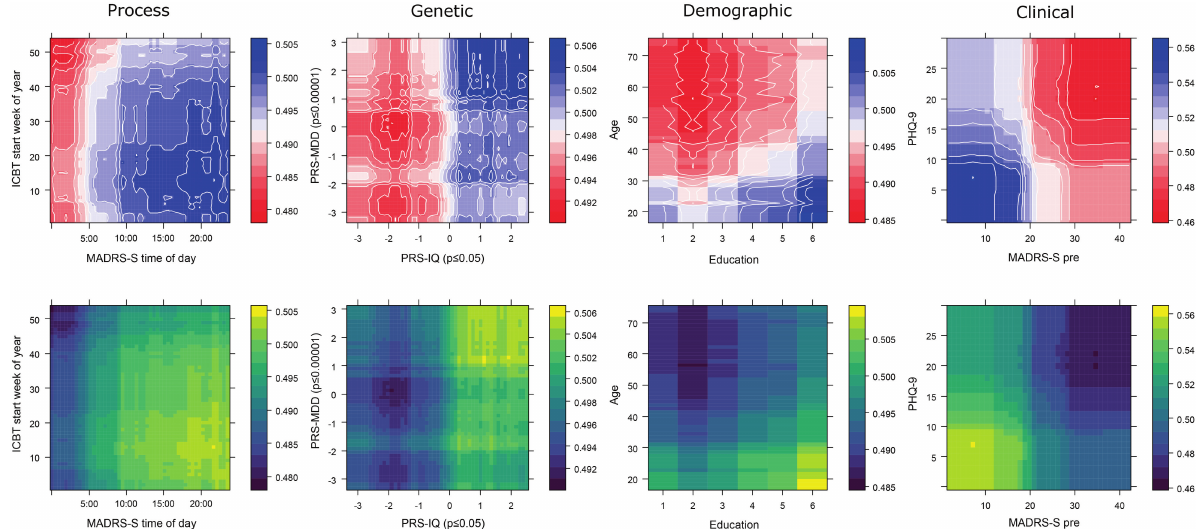
Fig. 4 Partial prediction plots of the strongest two predictors by predictor type. Each column represents one of the four predictor types from which the two top numeric predictors have been plotted on their respective x and y axis. Colour represents the individual variable contribution to the predicted probability of remission in two ways. The upper panel row is colour-blindness friendly (Blue = higher probability of remission) and the bottom row is greyscale compatible (Light = higher probability of remission). The probability contribution of each variable in each panel is calculated when all other predictors in the model are centred and held